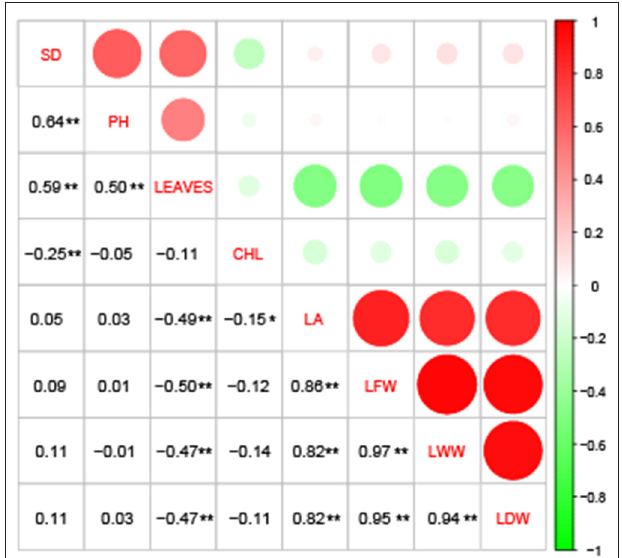
FIGURE 1 | Correlation analysis among the eight drought-tolerance traits of Gossypium hirsutum races. CHL, chlorophyll content; LA, leaf area; PH, plant height; SD, stem diameter; LEAVES, number of leaves; LFW, leaf fresh weight; LWW, leaf wilted weight; and LDW, leaf dry weight. *, significant at the α = 0.05 level; **, significant at the α = 0.01 level.